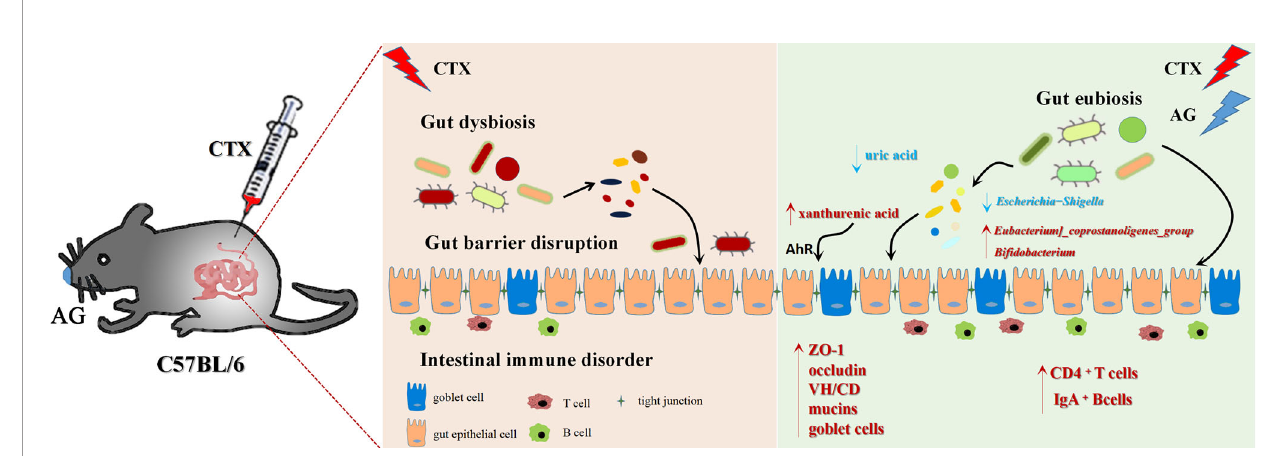
FIGURE 10 | Summarized mechanisms underlying the immunomodulatory effect of AG on CTX induced intestinal immune disorder and gut